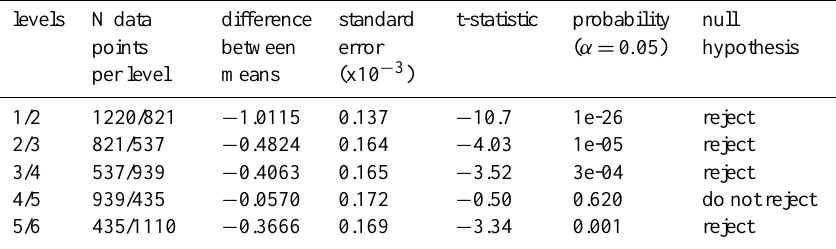
Table 2. T-test results for adjacent means of the aerosol concentration profile on 28 August.